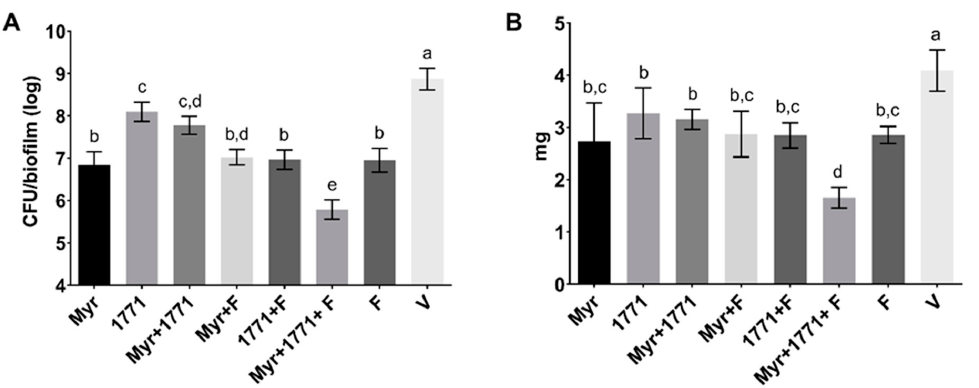
Figure 5. S. mutans viable counts ( A ) and insoluble biomass (dry-weight) ( B ) of topically treated biofilms. At 67 h, the vehicle yielded the highest values of CFU / biofilm and biomass, while the lowest values were found for the combination of Myr + 1771 + F. Bars with the same letters indicate no statistical di ff erence between the di ff erent treatments in each graph ( p > 0.05; one-way ANOVA, followed by Tukey’s test). The data represented are the means, and the error bars correspond to the standard deviation.